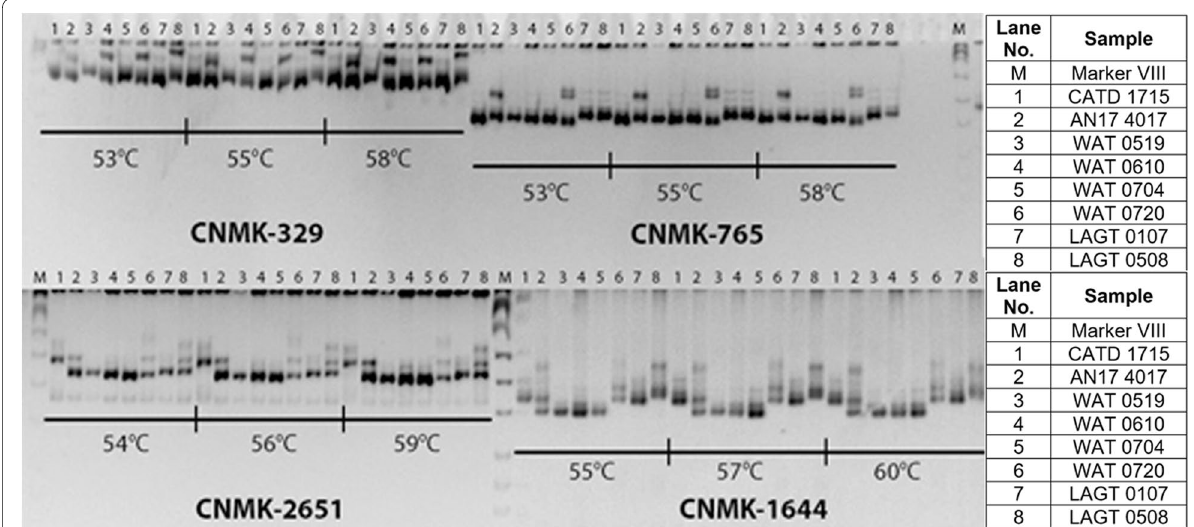
Fig. 3 Representative gels of polymorphic SSRs optimized among coconut